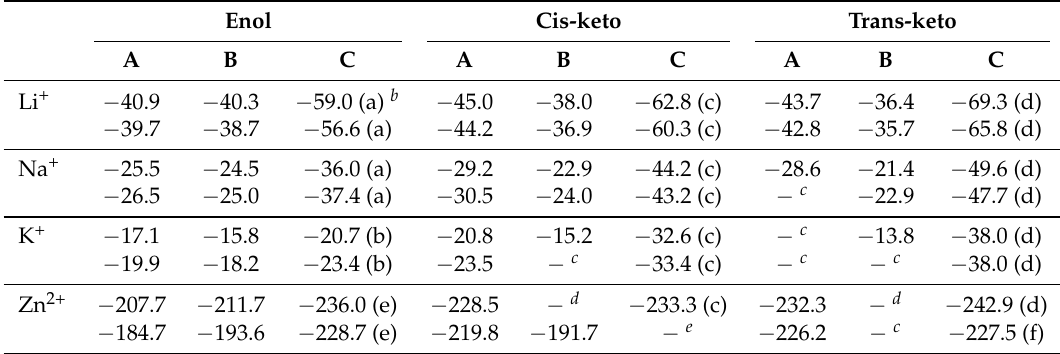
Table 1. Stabilization energies ∆ E (in kcal/mol) of SA@M complexes A to C (Figure 1) with the Li + , Na + , K + and Zn 2+ ions a .